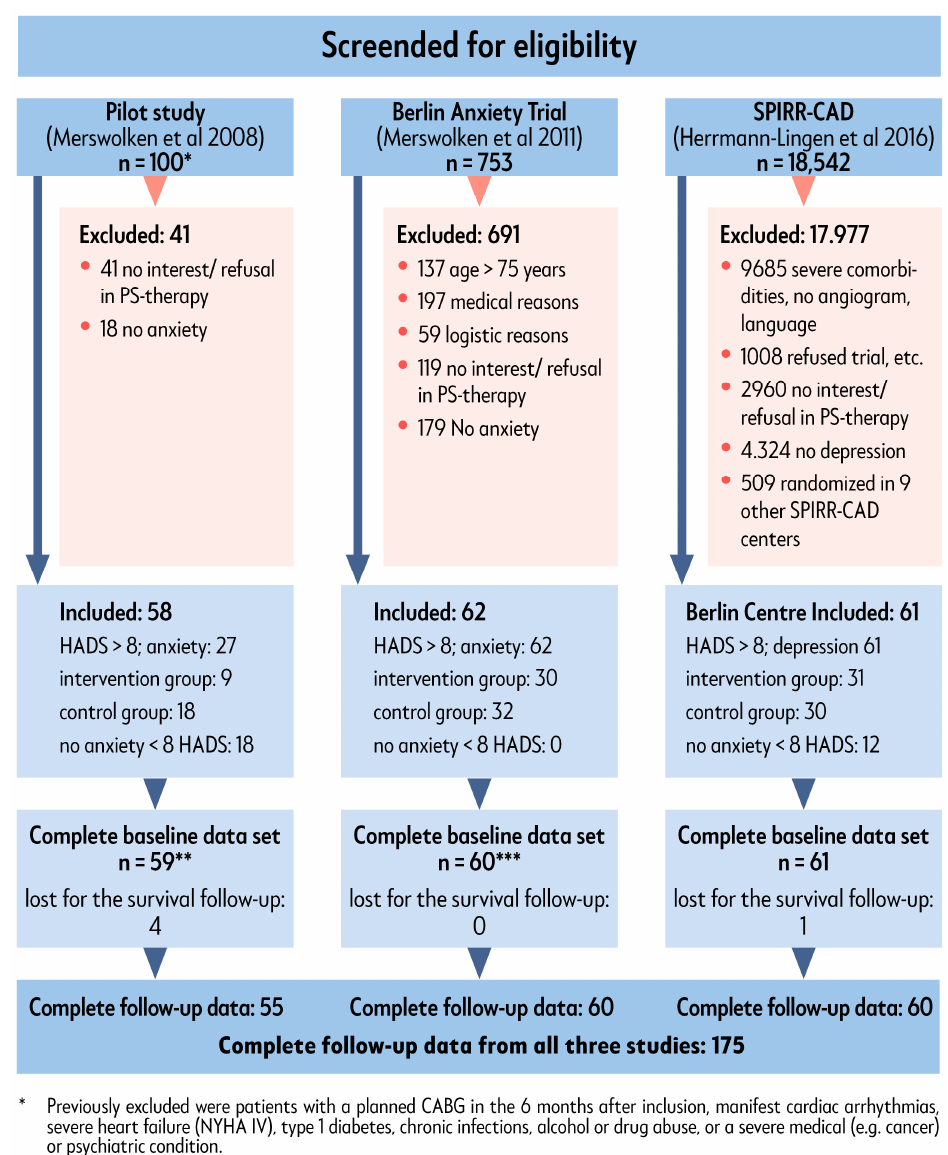
Figure 1. Flow chart